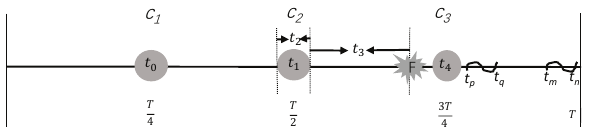
Figure 5. The time overhead of a